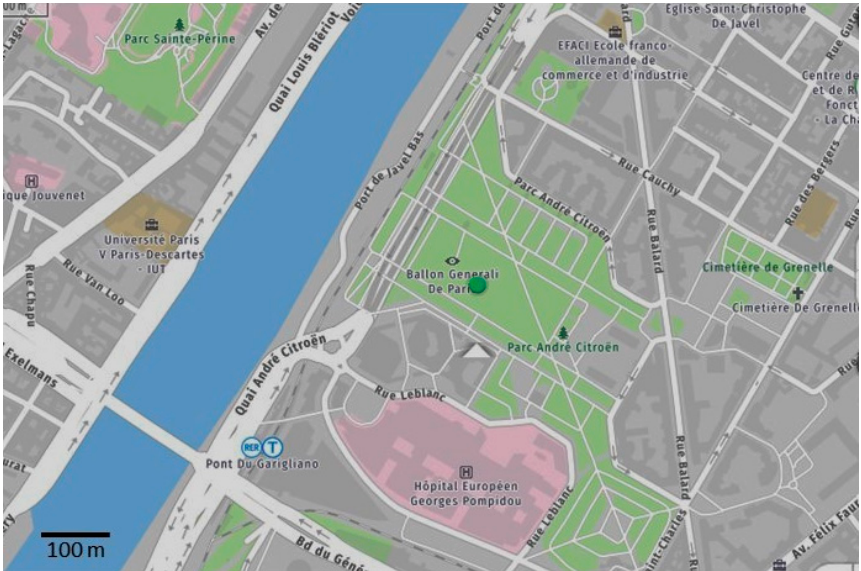
Figure 3. Map of the vicinity of the “Parc André Citroën” (the green dot represents the balloon location, map from mappy.com).